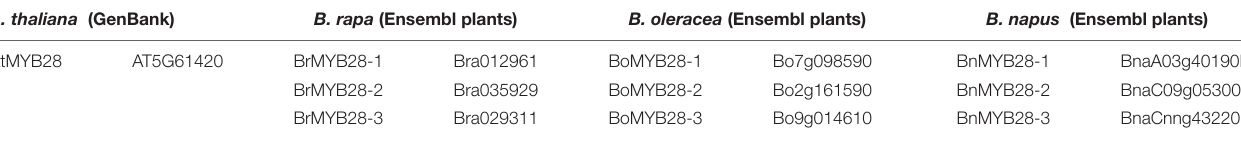
TABLE 2 | Ortholog list of transcription factors involved in GSL biosynthesis in B. napus